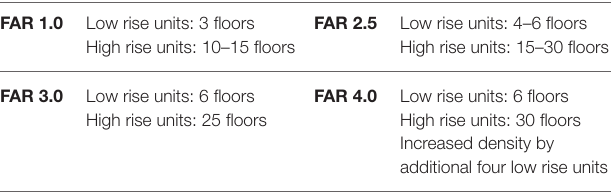
TABLE 1 | FAR description for four modelled FARs of 1.0, 2.5, 3.0, and